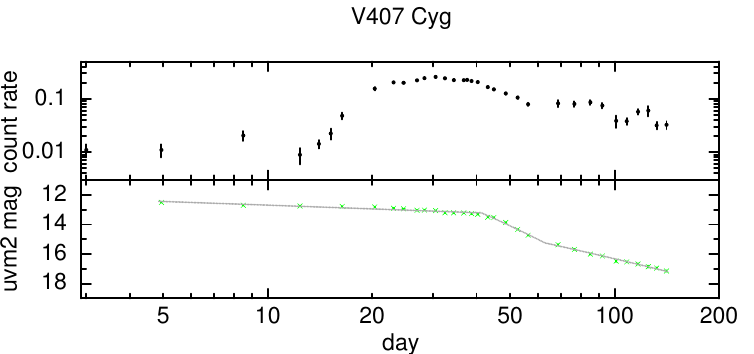
Figure 4. The XRT and UVOT light-curves of V407 Cyg, with the best-fit broken power-law decline shown as the grey solid line. The X-ray data (top) are in count s − 1 over 0.3–10 keV.